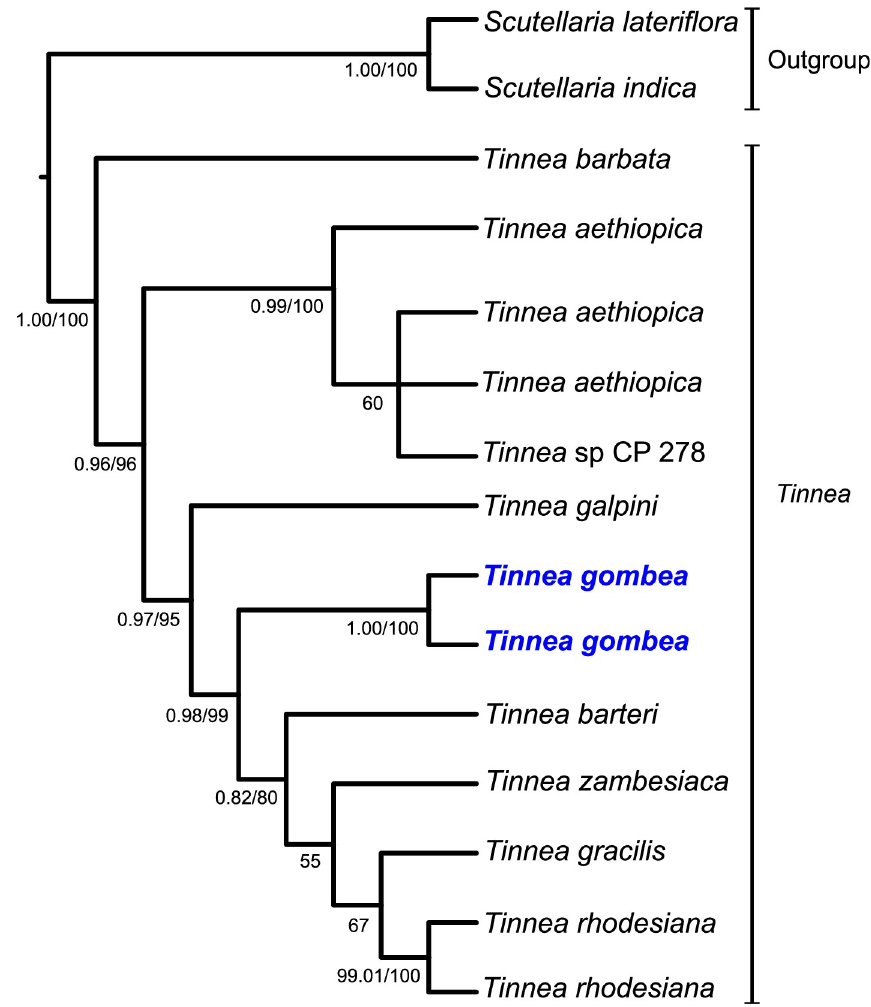
Fig 1. A 50% majority-rule consensus tree of the genus Tinnea obtained from the Bayesian analysis of the combined datasets of the nrITS, and matK , rbcL and trnL-F . Numbers on nodes indicate the posterior probability and the bootstrap support values of > 0.80 and > 55% respectively. Note that the new species ( T . gombea ) is in bold